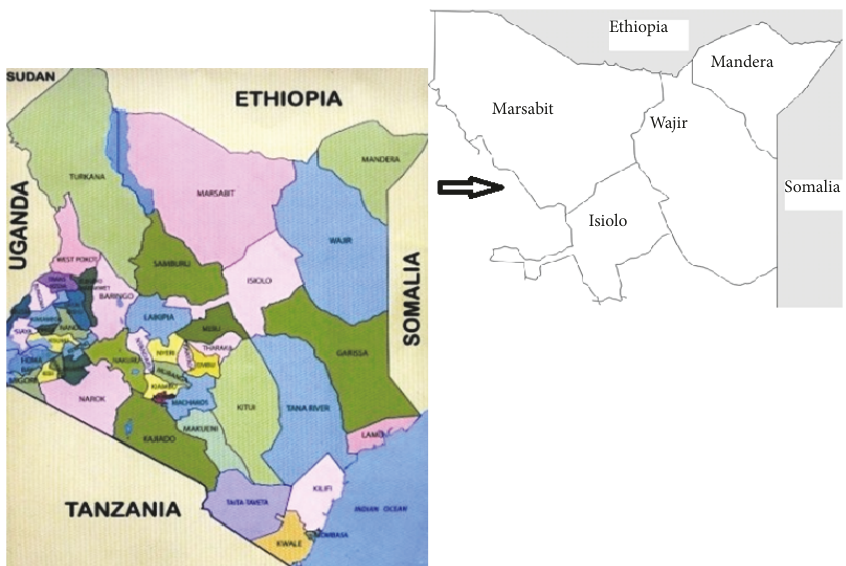
Figure 1: Map showing the study